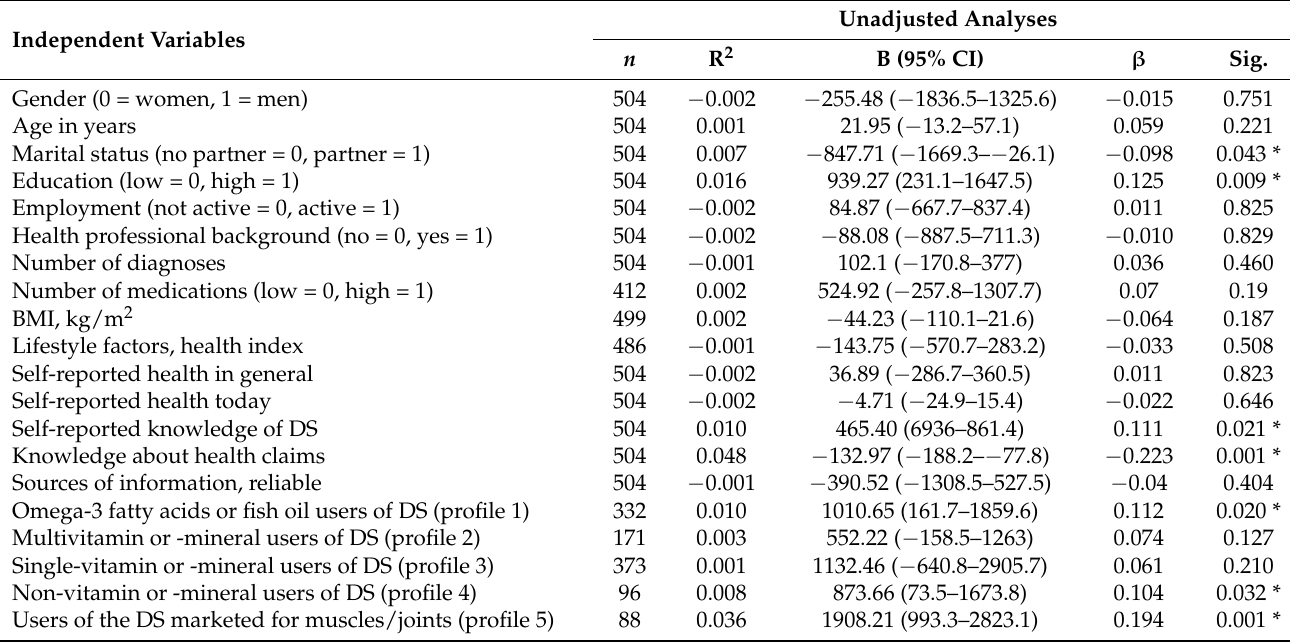
Table 5. Unadjusted linear regression of the association between estimated money spent on DS in the last year and variables measuring demographics, lifestyle factors, health conditions, knowledge about DS, and subgroups of